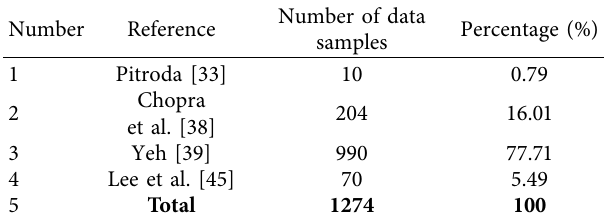
Table 1: Detail of database